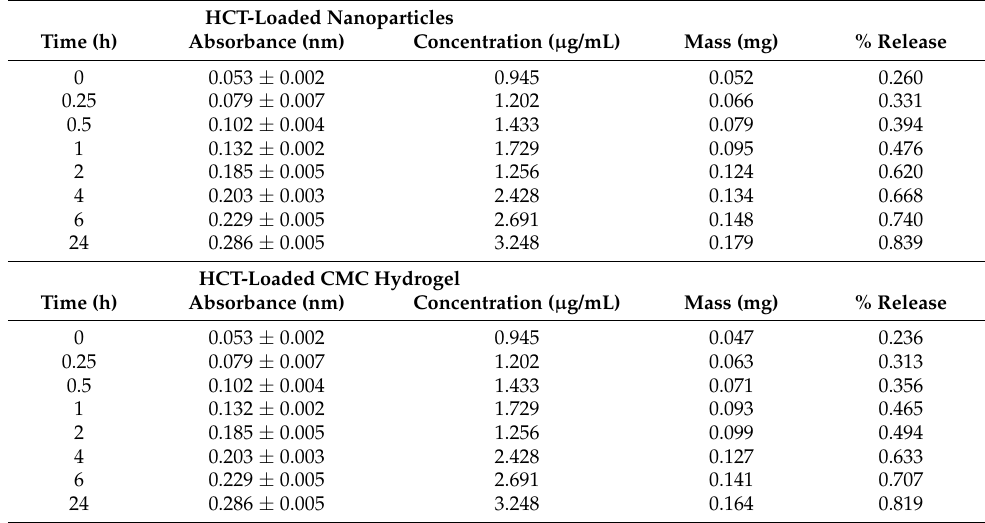
Table 2. HCT drug-release profiles at pH